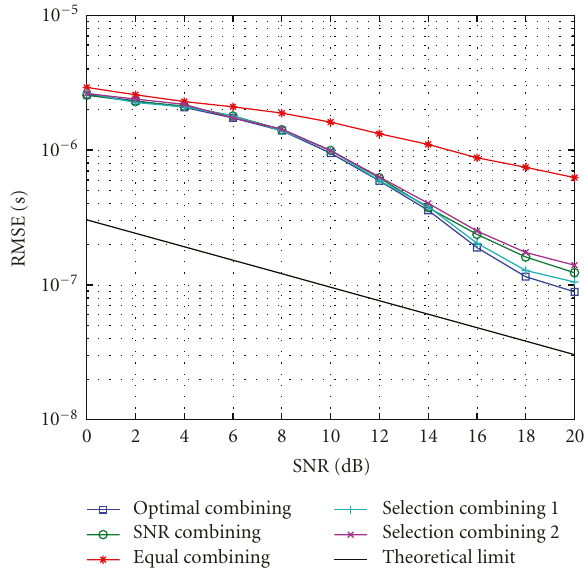
Figure 8: RMSE versus SNR for the proposed algorithms, and the theoretical limit (CRLB) in the presence of CFO. The signal occupies two dispersed bands with bandwidths B 1 = 100 kHz and B 2 = 400